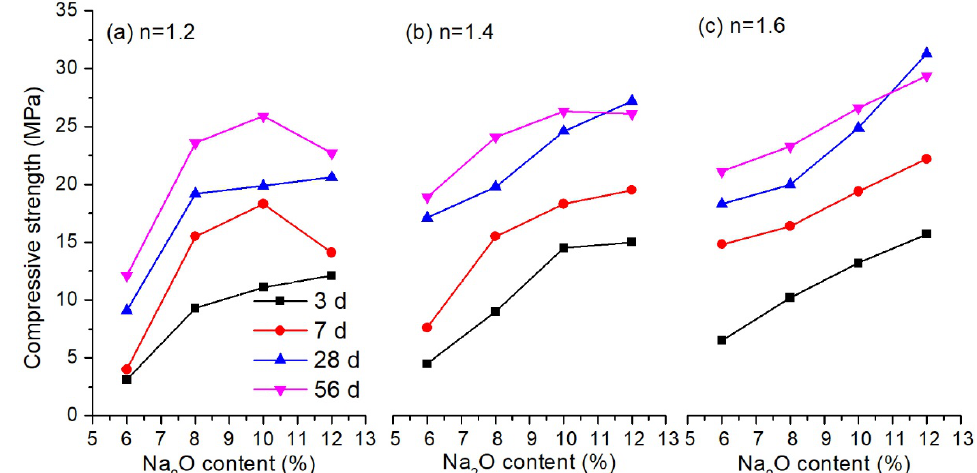
Figure 4. Compressive strength of alkali activated LFA-GGBS hybrid binder with different alkali solution (GGBS content = 25%, water / solid ratio = 0.4): ( a ) modulus of water glass n = 1.2; ( b ) modulus of water glass n = 1.4; ( c ) modulus of water glass n = 1.6.